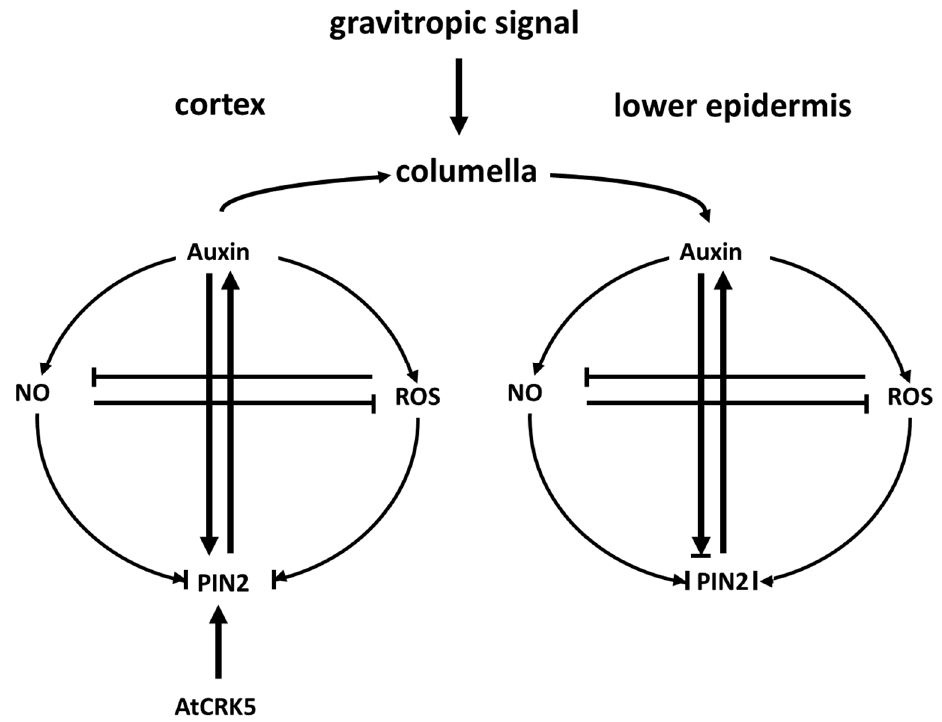
Figure 10. Hypothetical model integrating the current knowledge about the role of auxin, NO, ROS, and AtCRK5 kinase in the root gravitropic response in Arabidopsis. Arrowheads indicate positive, blunt ends indicate negative regulation. Note that some of the interactions are only transient. Note that the effect of ROS, NO, and auxin on PIN2 endocytosis/turnover can be positive and negative depending on concentration and timing. For a detailed description see the text. NO—nitric oxide; ROS—reactive oxygen species; PIN2—PINOID 2 auxin efflux carrier; AtCRK5— Arabidopsis thaliana Calcium-Dependent Protein Kinase-Related Kinase 5.